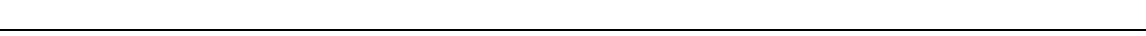
Fig. 6 Impaired periosteum in Periostin KO mice. a Experimental design for the isolation of periosteum grafts from GFP or Periostin KO-GFP donors and transplantation at the fracture site of wild type (WT) hosts for lineage tracing of periosteum-derived cells during bone repair. b SO staining and DAPI/GFP immuno fl uorescence on longitudinal callus sections at day 14 reveals decreased contribution KO-GFP grafts (KO in WT) compared to GFP grafts (WT in WT) (arrowheads). Quanti fi cation of GFP signal shows decreased volume in callus and cartilage for KO-GFP grafts compared to GFP grafts. Scale bar: 1 mm. c CFE assay on activated PCs isolated from WT and KO mice and plated at 400 cells/cm 2 for 14 days. Colonies were stained with Giemsa blue and counted. d In vitro differentiation assays of activated PCs isolated from WT and KO mice shows osteogenic differentiation (alizarin red S stain) at 2 weeks for WT PCs, but not for KO PCs (left) and at 5 weeks for WT and KO PCs (right). Adipogenesis (Oil red O) is reduced in KO at 3 weeks and chondrogenesis (alcian blue stain) at 1 week is similar in WT and KO PCs. e Quantitative RT-PCR analyses of Periostin (Postn) -linked genes, some of them upregulated in PCs in response to injury and encoding ECM proteins (see Fig. 4i and Supplementary Table 3) in WT -PCs and KO PCs. f Experimental design for the isolation of activated PCs from GFP or KO-GFP mice and transplantation at the fracture site of KO hosts (WT in KO and KO in KO, respectively). g Periostin (POSTN/red) immuno fl uorescence on callus sections after transplantation of WT PCs (GFP/green) in KO hosts. PCs express POSTN when they integrate into the callus (Merge/Yellow, left and boxes 1 and 2) and stop expressing POSTN when they differentiate (box 2, white arrowhead pointing to POSTN-negative and GFP-positive chondrocytes). Scale bar: 1 mm. h Histomorphometric analyses of callus, bone, and cartilage volumes at d14. Scale bar: 1 mm. SO: Safranin-O, c: cortex, ca: cartilage, cal: callus, white dashed line: bone, black dashed line: callus, merge: GFP + cells expressing POSTN. Statistical differences between the groups were determined using Mann – Whitney test (* p < 0.05) ( n = 3 or 4 per group). All data represent mean ±